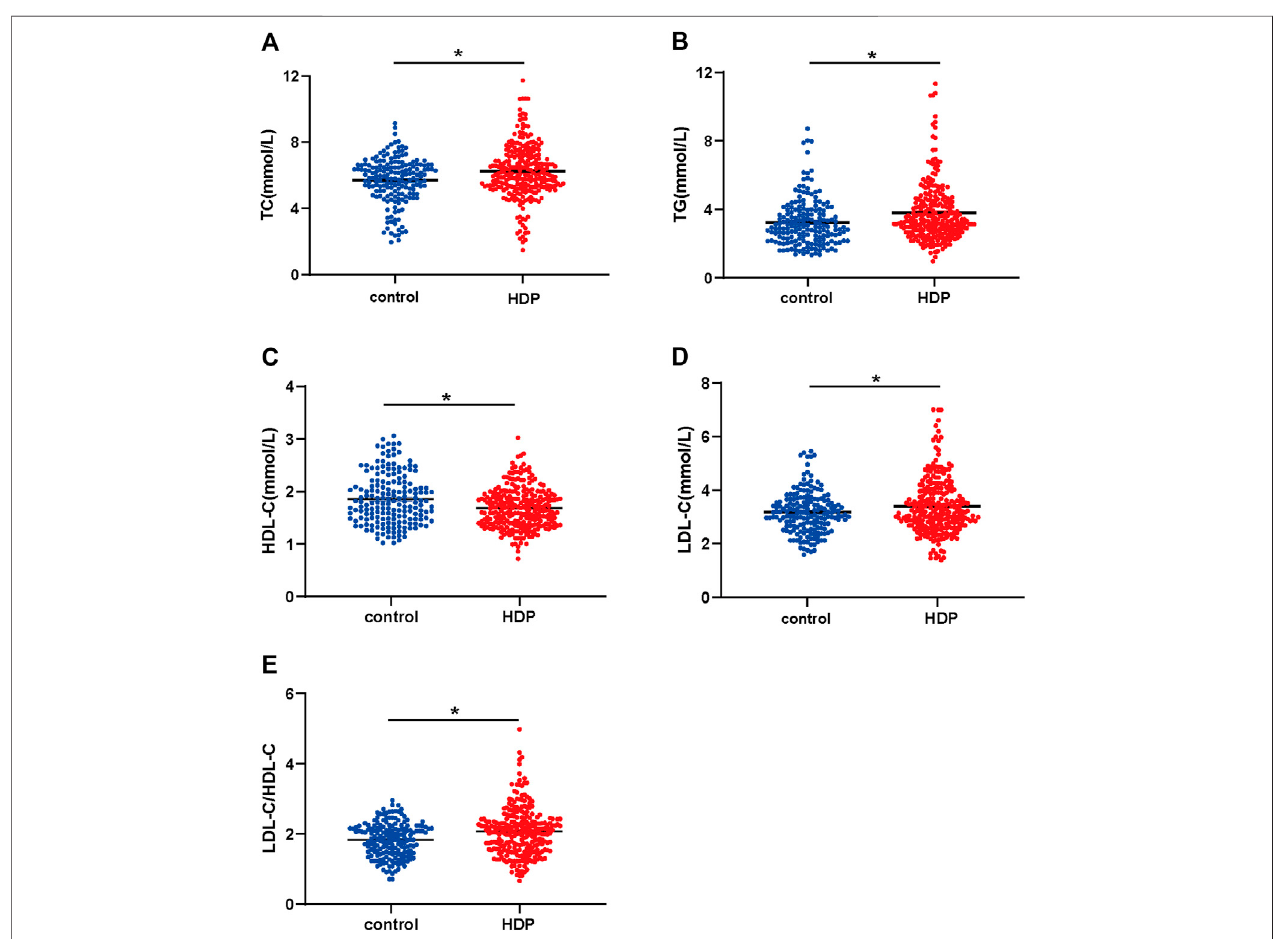
FIGURE 1 | Maternal plasma lipid pro fi le of the two groups. Plasma concentrations of TC (A), TG (B), LDL-C (C), HDL-C (D), and LDL-C/HDL-C ratio (E) were compared in the HDP group ( n (cid:1) 265) and the control group ( n (cid:1) 178). HDP, hypertensive disorders of pregnancy; TC, total cholesterol; TG, total triglycerides; HDL-C, high-density lipoprotein cholesterol; LDL-C, low-density lipoprotein cholesterol. * p < 0.01, compared with the control group.